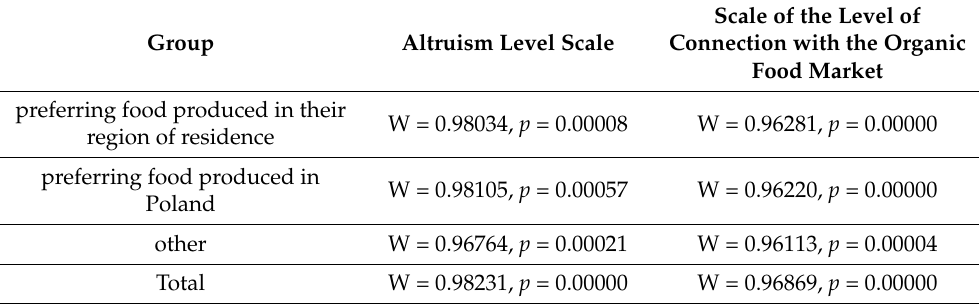
Table 1. Normal distribution analysis—Shapiro–Wilk test results.